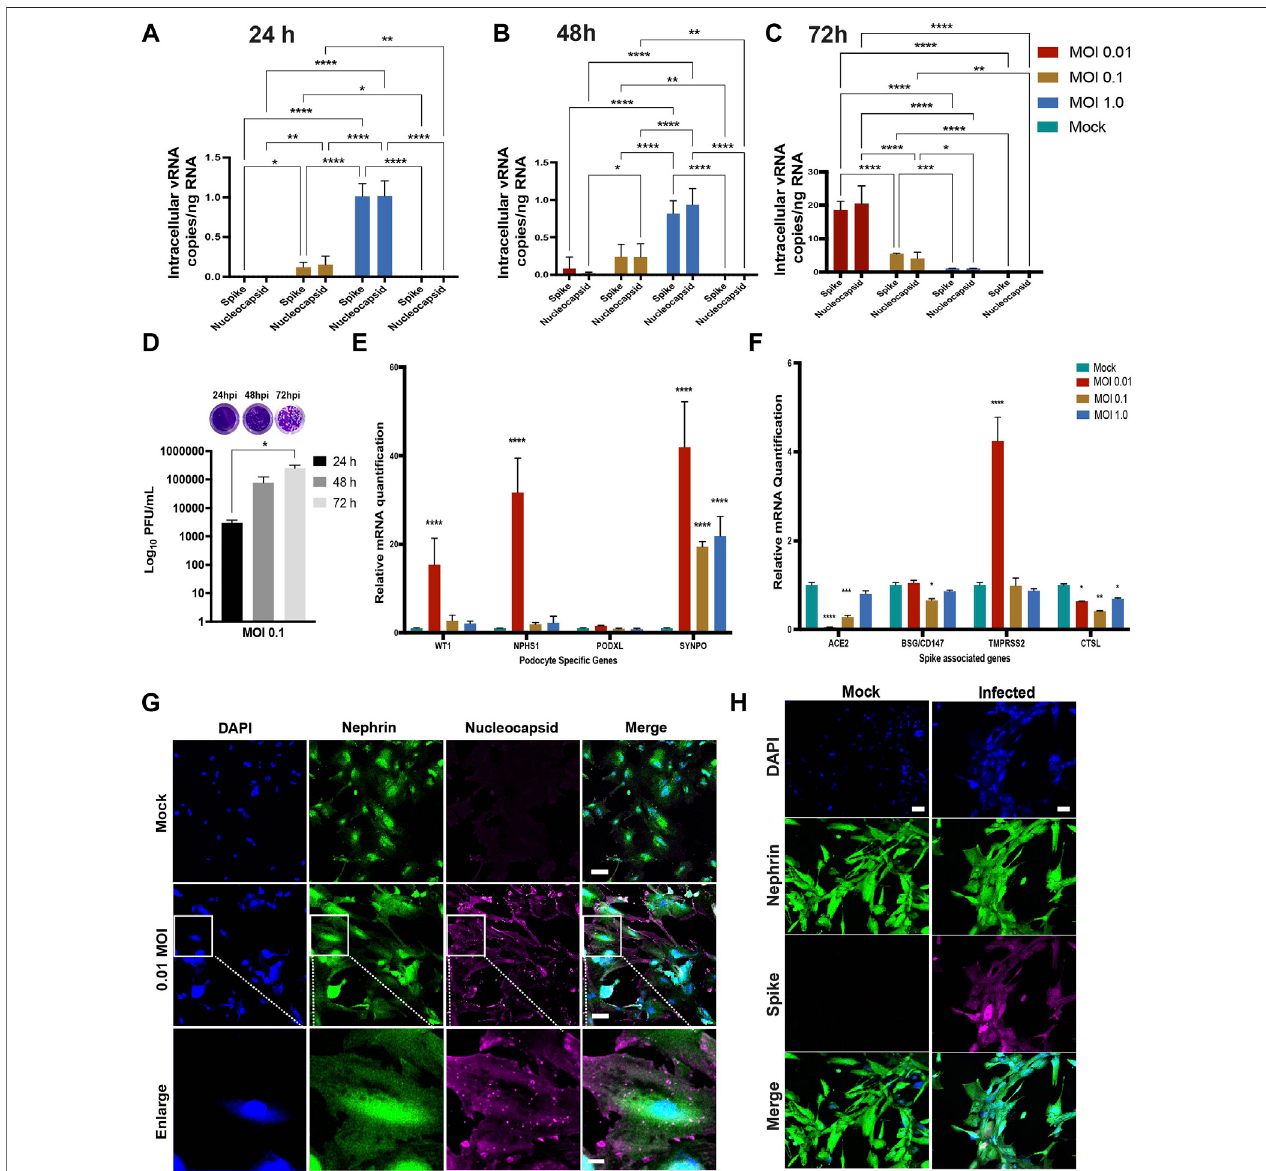
FIGURE3| Susceptibility ofhuman iPS cell-derived podocytes toinfection byliveSARS-CoV-2. qPCR analysisofhumaniPS cell-derived podocytes infected with SARS-CoV-2 revealed intracellular uptake of the virus for 24 h.p.i (A) , 48 h.p.i (B) and 72 h.p.i (C) . (D) plaque assay quanti fi cation from supernatant obtained from infected podocytes at 24, 48 and 72 h.p.i. (E) qPCR analysis of podocyte-speci fi c genes revealed that both synaptopodin (SYNPO) and podocalyxin (PODXL) are signi fi cantly upregulated after infection with SARS-CoV-2 at MOI of 0.01, whereas SYNPO is signi fi cantly upregulated at multiple MOIs, and PODXL shows no signi fi cant changes with viral infection. (F) The expression of spike-associated genes (ACE2, BSG/CD147) and spike processing genes (TMPRSS2, CTSL) are signi fi cantly impacted by infection at MOIs of 0.01 and 0.1, respectively. (G) Human iPS cell-derived podocytes treated with SARS-CoV-2 (at MOI of 0.01) immunostain positive for Nucleocapsid protein (magenta), indicating successful infection with the virus. The cells were immunostained also for the podocyte marker Nephrin (green) and counterstained withDAPI (blue). Scale bar:100 µm (H) Spike positive cells Nephrinand DAPIasnuclearcounterstaininthe infected podocytes.Scale bar: 100 µm. One-way analysis of variance (ANOVA) with Sidak ’ s multiple comparison test was used to determine statistical signi fi cance. Only p values of 0.05 or lower were considered statistically signi fi cant ( p > 0.05 [ns, not signi fi cant], p < 0.05 [*], p < 0.01 [**], p < 0.001 [***], p < 0.0001 [****]). Error bars indicate standard deviation of the